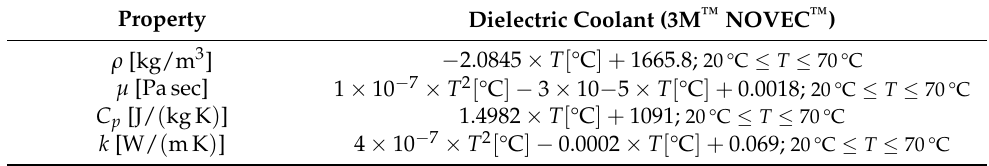
Table 1. Temperature dependent thermo-physical properties of dielectric coolant used for immersion cooling of the battery module